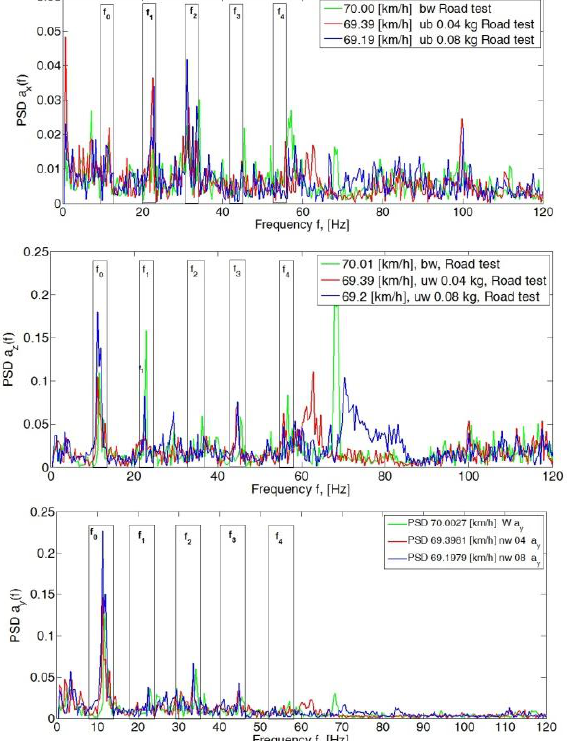
Figure 6. Power spectral density graph of the body acceleration signal for a speed of 70 km/h. The subsequent increase in speed to 80 km/h, 90 km/h and 100 km/h showed a significant dominance of amplitudes in the y - and z -directions. In the longitudinal direction ( x -axis), PSD peak values still did not exceed 0.15 (Figures 7–9).